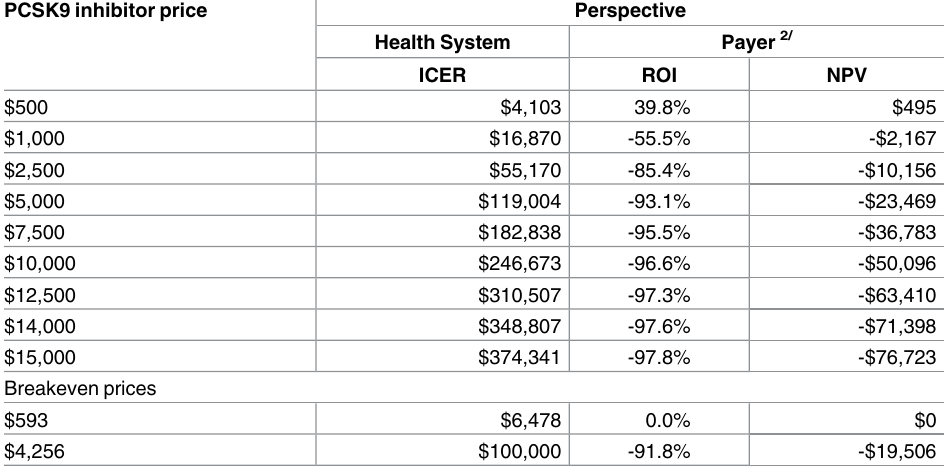
Table 3. CEA and ROI analysis at Different Prices of PCSK9 (Health System’sand Payer’sPerspec- tive) 1/